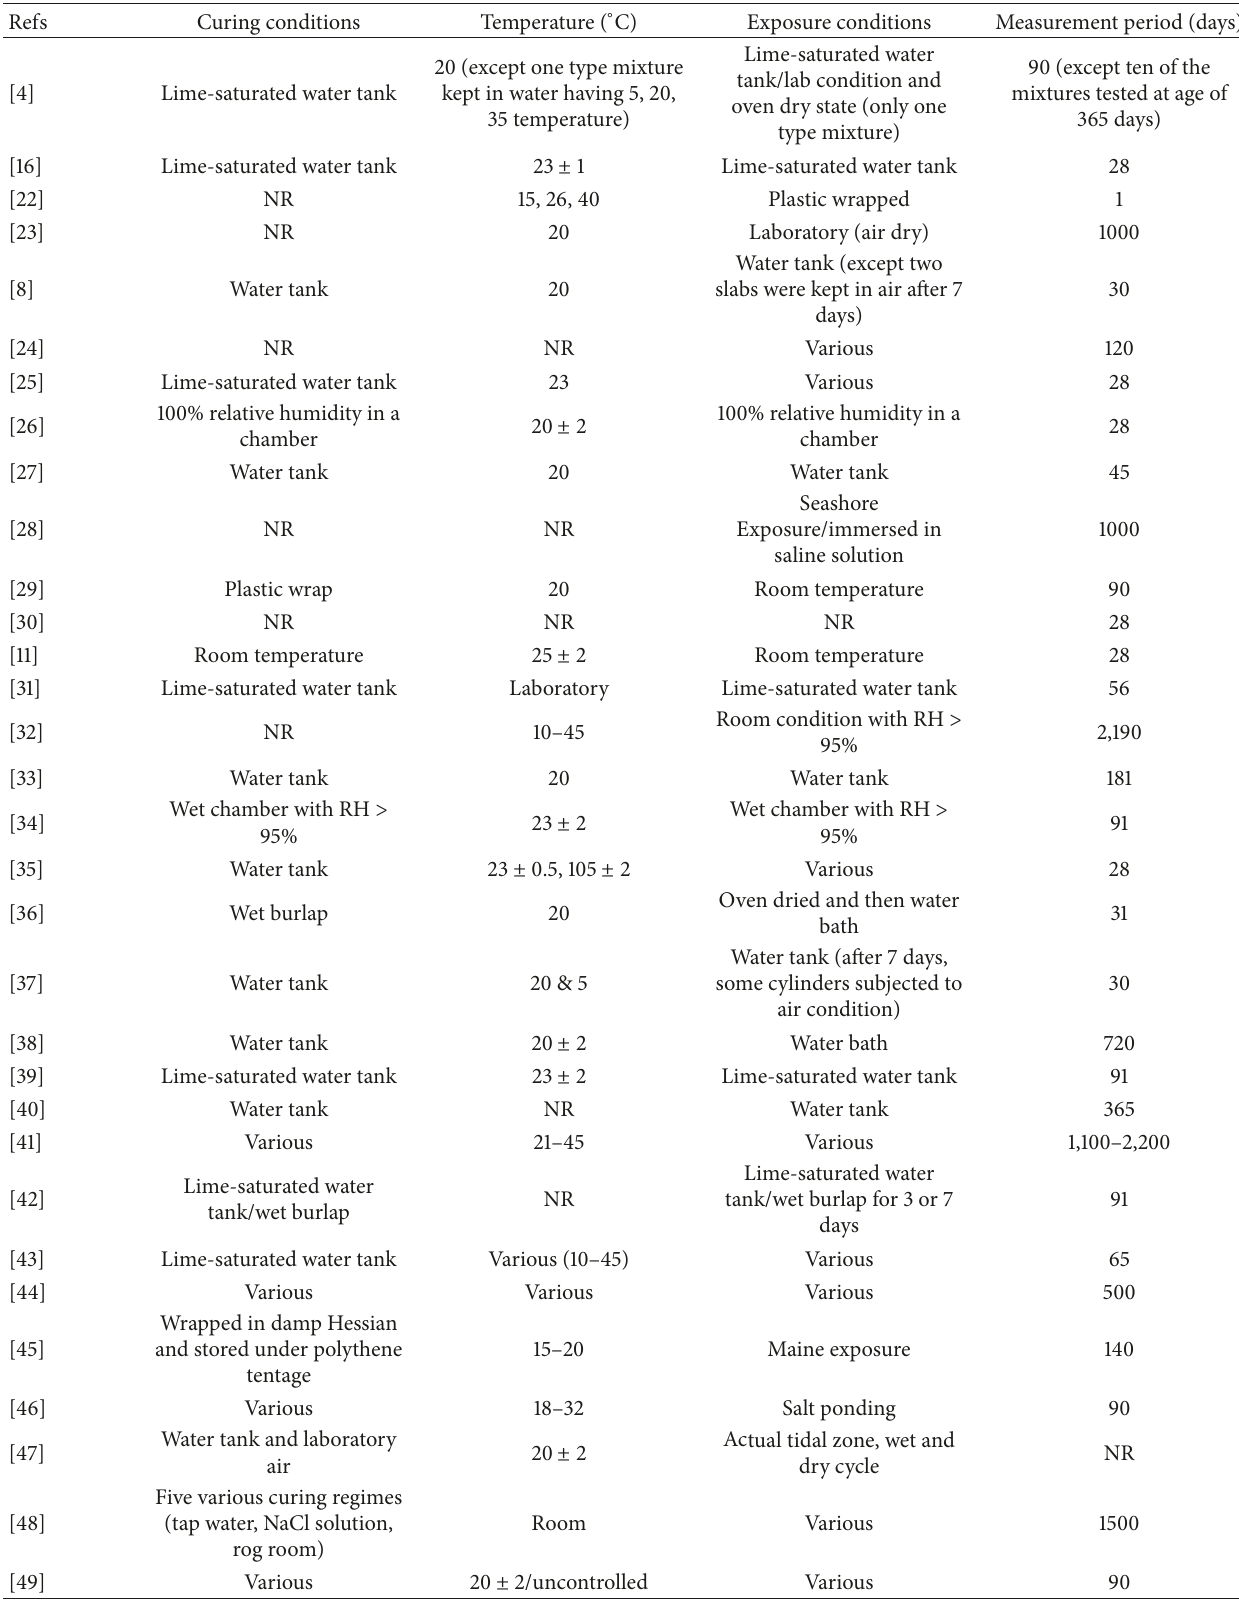
Table 3: Details of the curing conditions, exposure conditions, and measurement